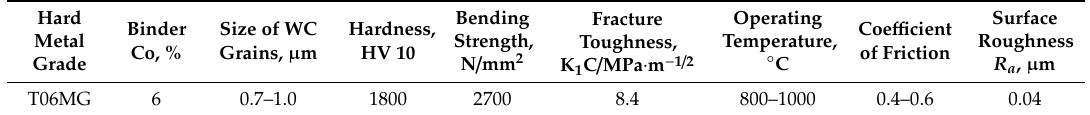
Table 1. Hard metal characteristics